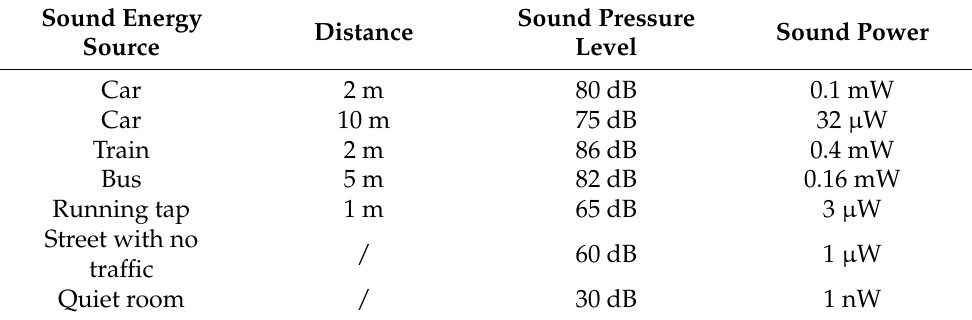
Table 1. Sound pressure level and sound power of common sound